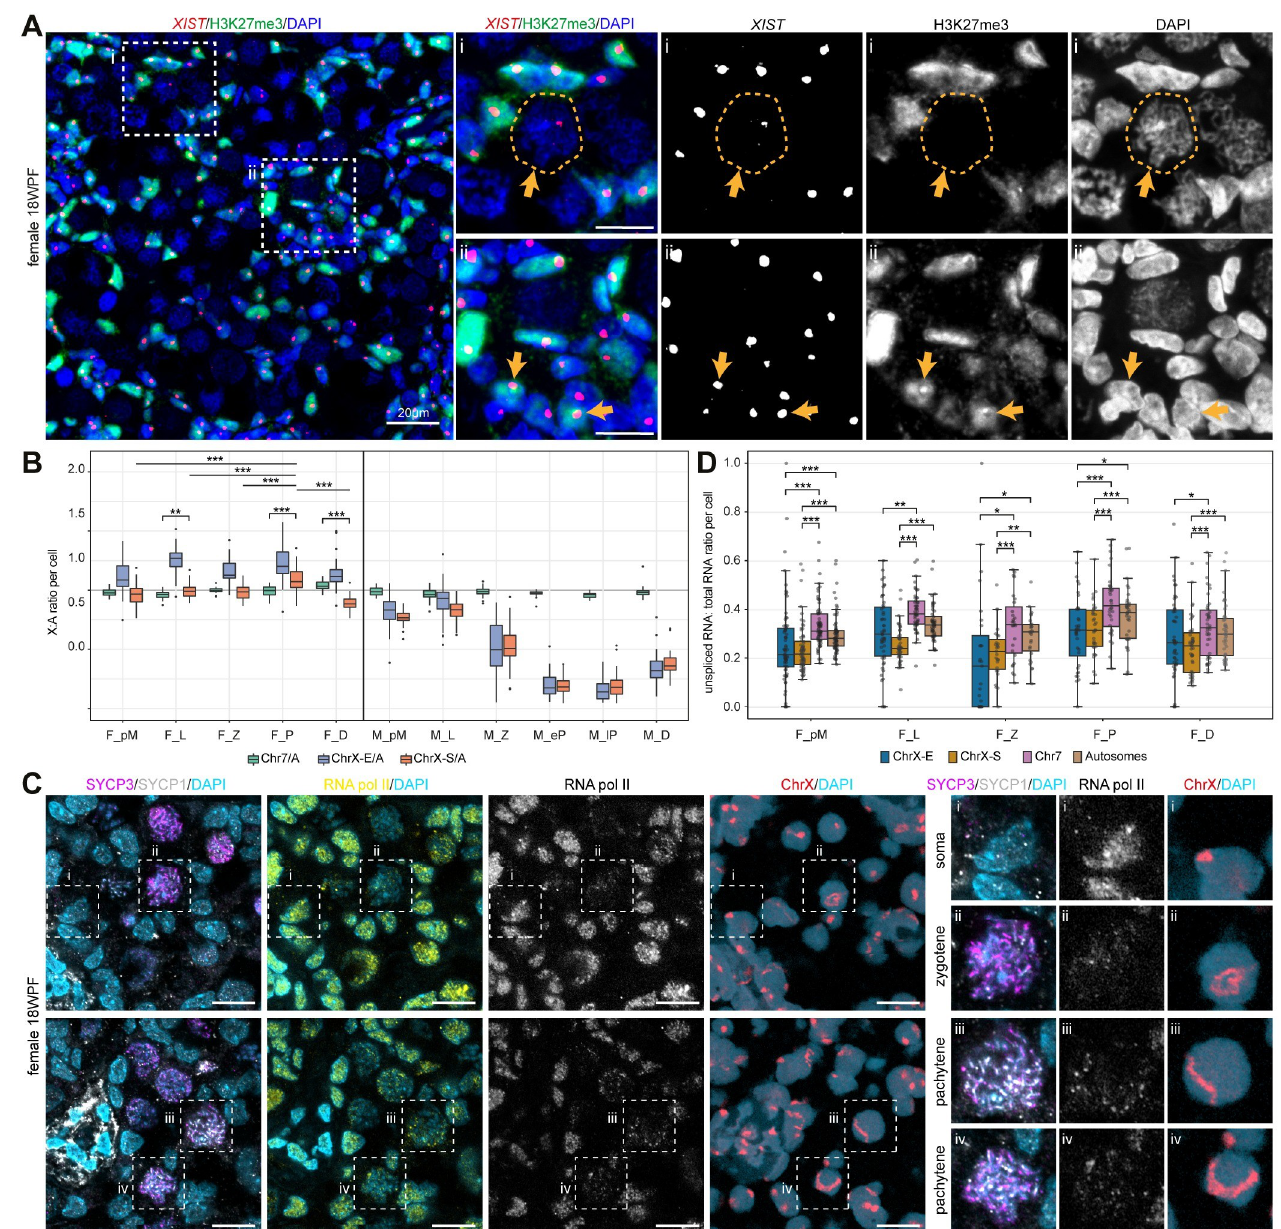
Fig 6. X-linked dynamics between sexes during meiotic prophase I. (A) RNA FISH for XIST combined with immunofluorescence for H3K27me3 in 18WFP ovaries. White dashed boxes indicate selected FGC, magnified on the right. i, orange arrows and dashed lines indicate a meiotic FGC showing XIST without H3K27me3; ii, orange arrows indicate somatic cells showing co-localization of XIST and H3K27me3. Scale bars are 20 μ m in the overview image (left) and 10 μ m in the high magnification images (right). (B) Box plot showing the ratio of mean expression of genes per cell from Chr7, ChrX-E and ChrX-S and mean expression of autosomes per cell. M-pM are male spermatogonial stem cells/spermatogonia cluster (mCL2); F_pM, female pre-meiotic germ cells; F_L, female leptotene; F_Z, female zygotene; F_P, female pachytene; F_D, female dictyate/diplotene; M_pM, male pre-meiotic germ cells; M_L, male leptotene; M_Z, male zygotene; M_eP, male early-pachytene; M_lP, male late-pachytene; M_D, male diplotene. Statistical significance was assessed using Wilcoxon rank-sum test or Wilcoxon signed-rank test for female germ cells, �� P < 0.01, ��� P < 0.001. (C) Immunofluorescence for SYCP3, SYCP1 and RNA pol II in 18WFP ovaries, sequentially used for DNA FISH of ChrX (image of the same region). Dashed boxes are showed in high magnification on the right. Scale bars are 10 μ m. (D) Box plot showing the ratio of unspliced RNA to total RNA for genes form Chr7, ChrX-E, ChrX-S and all autosomes per cell. Statistical significance was assessed using Wilcoxon signed-rank test for different groups in cells from each stage, � P < 0.05, �� P < 0.01, ��� P < 0.001.